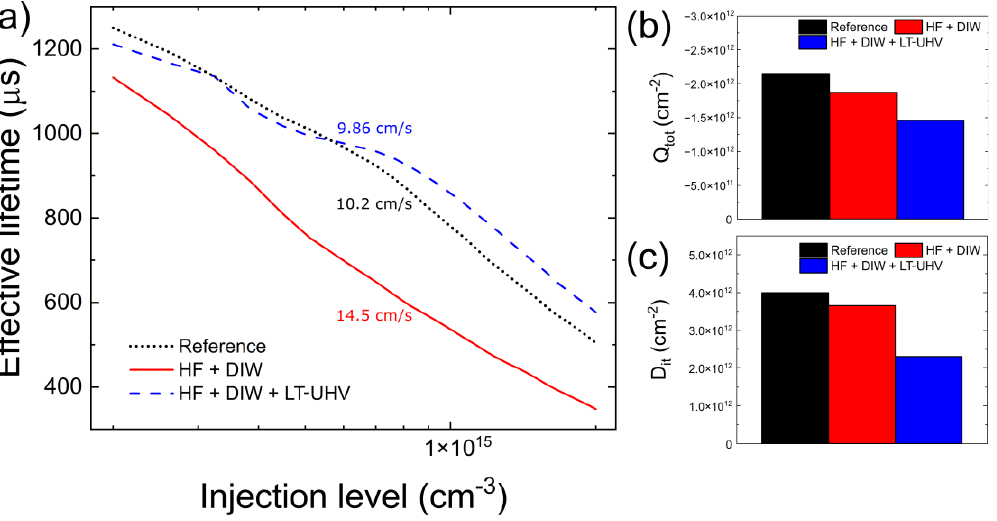
Figure 4. ( a ) Injection-dependent τ eff of ALD-Al 2 O 3 -coated samples with different combinations of pretreatments (Reference (HCl), HF + DIW, and HF + DIW + LT-UHV treatment). All samples were post-deposition-annealed for 30 min at 400 °C in N 2 ambient. The value labelled for each curve represents the corresponding SRV extracted at 7 × 10 14 cm −3 injection level. Extracted ( b ) Q tot and ( c ) D it values measured using COCOS.